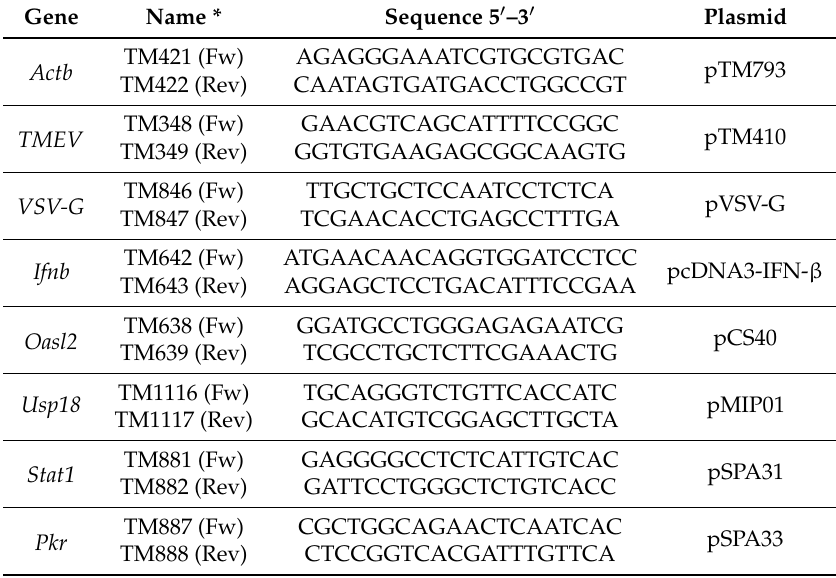
Table 3. Primers used for gene expression analysis by RT-qPCR and reference